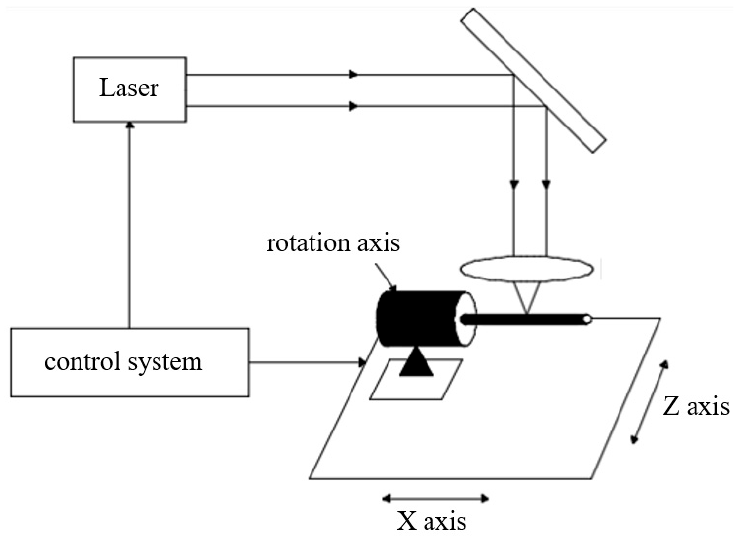
Figure 2. Laser cutting process of a vascular stent.